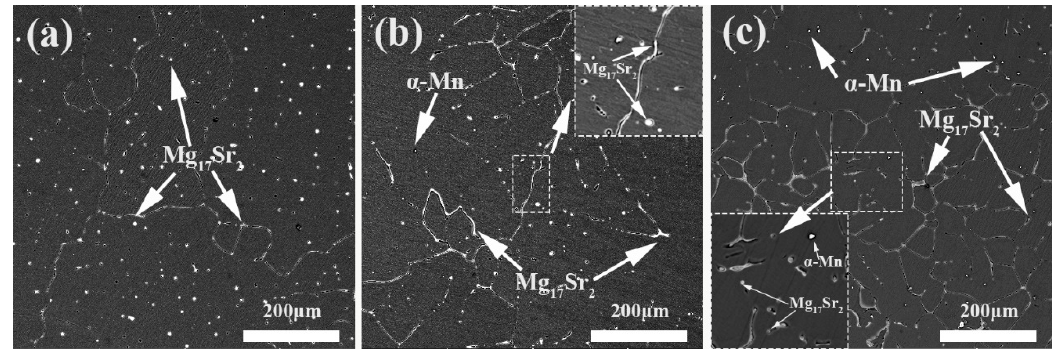
Figure 2. SEM-BSE micrographs of as-cast Mg-0.5Sr-xMn alloys: ( a ) x = 0 wt.%, ( b ) x = 1 wt.%, ( c ) x = 2 wt.%.